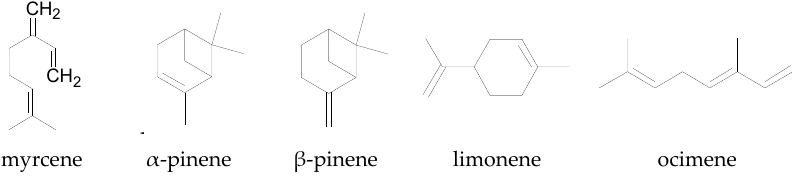
Figure 5 . Chemical structures of some monoterpenes in plants, including cotton. Figure 5. Chemical structures of some monoterpenes in plants, including cotton.